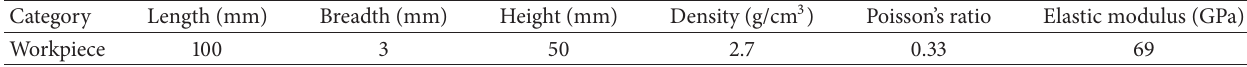
Table 1: Geometrical parameters of